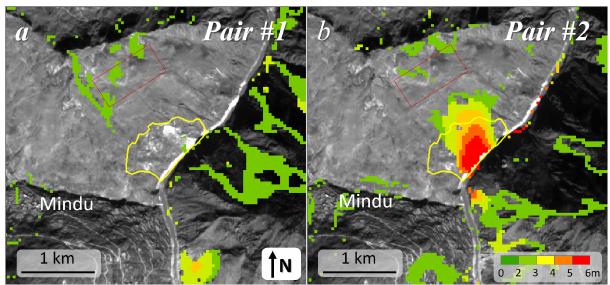
Figure 2. Detected slope displacements in image pair no. 1 (a) and no. 2. (b) . Background Sentinel-2 images were acquired on 13 November 2015 and 12 November 2018, respectively. Both images were produced by ESA’s Sentinel-2 satellites and downloaded via the GEE.